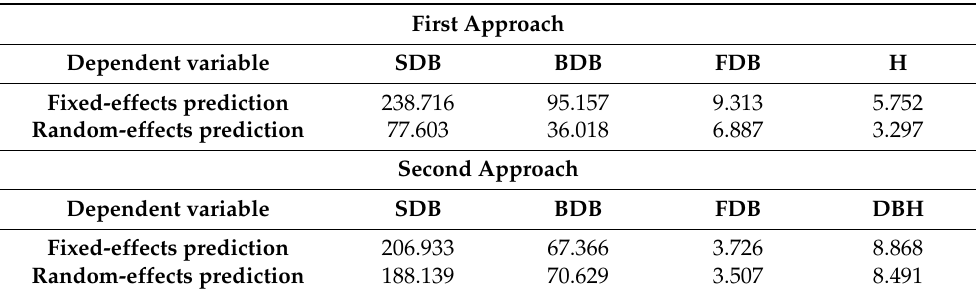
Table 6. Root mean square error achieved during cross-model fixed and random-effects prediction for both approaches of seemingly unrelated mixed-effects model